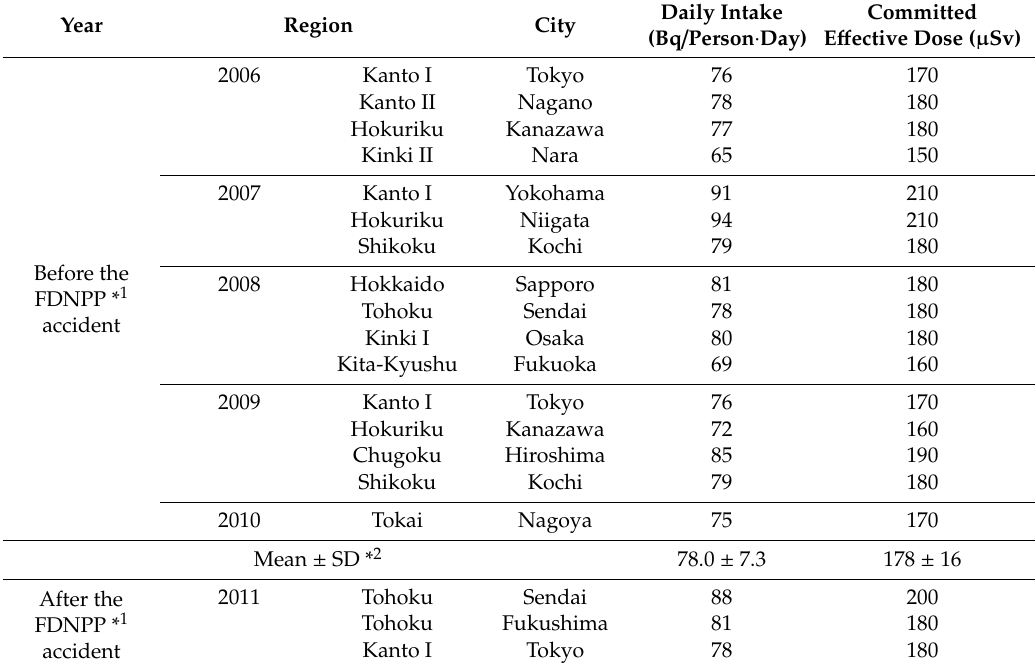
Table 5. Total daily dietary intake values and committed e ff ective doses of 40 K for adults in Japan, estimated via total diet studies from 2006 to